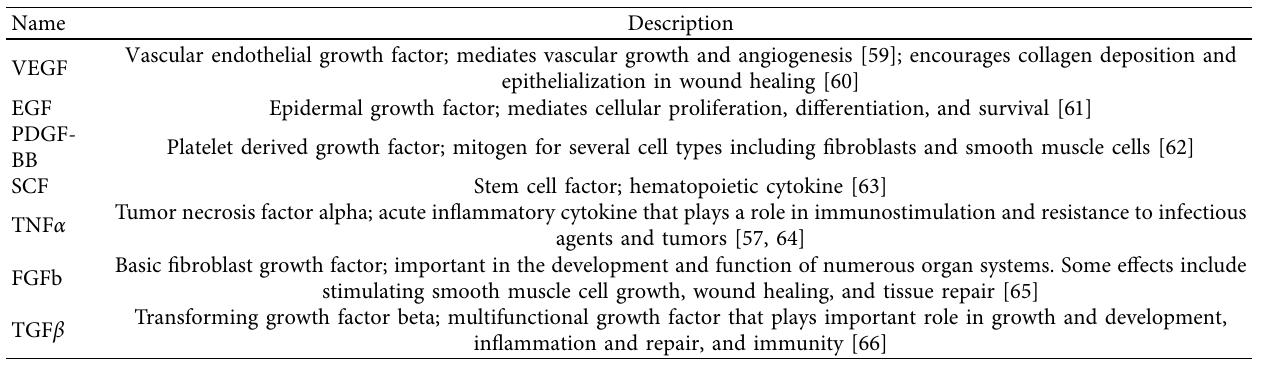
Table 3: Description of growth factors targeted in